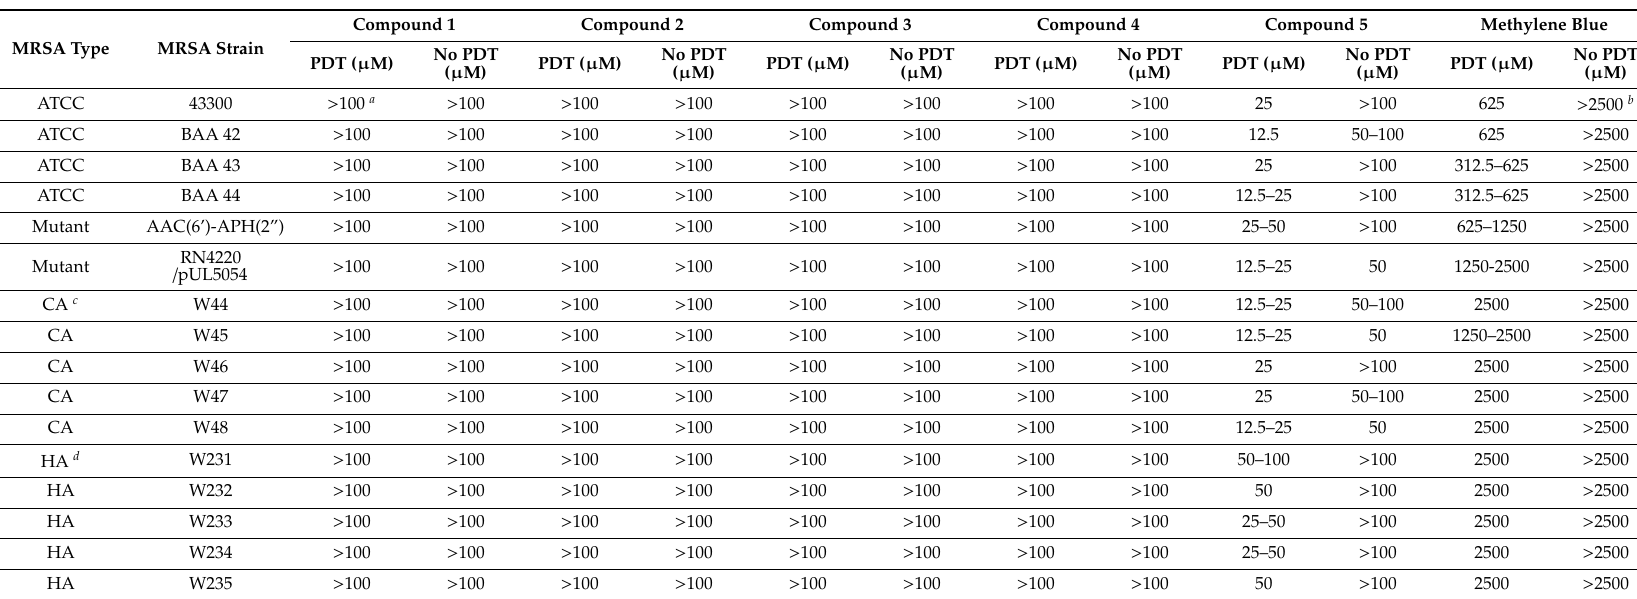
Table 2. Minimal bactericidal concentrations (MBCs) of 1 – 5 and methylene blue against 16 methicillin-resistant Staphylococcus aureus (MRSA)